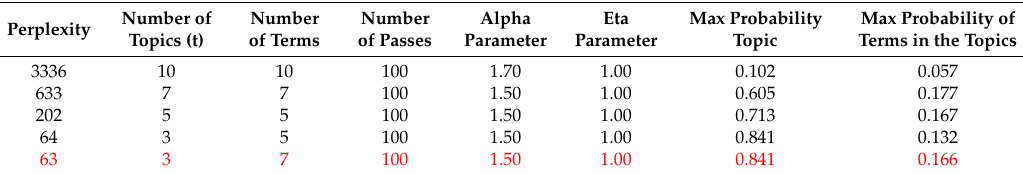
Table 1. Results of the Study of the LDA Model Parameters.